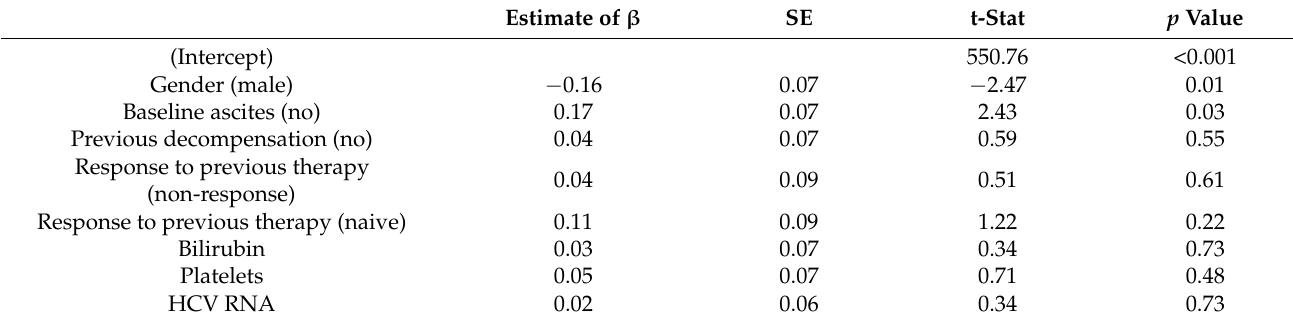
Table 8. Baseline factors associated with SVR based on the logistic regression model.